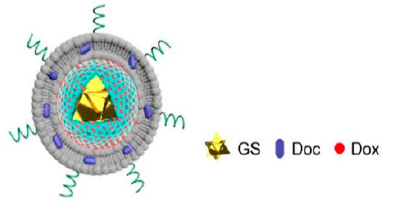
Figure 2. Schematic diagram of gold nanostar-liposome-entrapped mesoporous silica core/shell nanostructure. This image was reproduced with permission from [58]. Copyright ©, 2020, American Chemical Society.